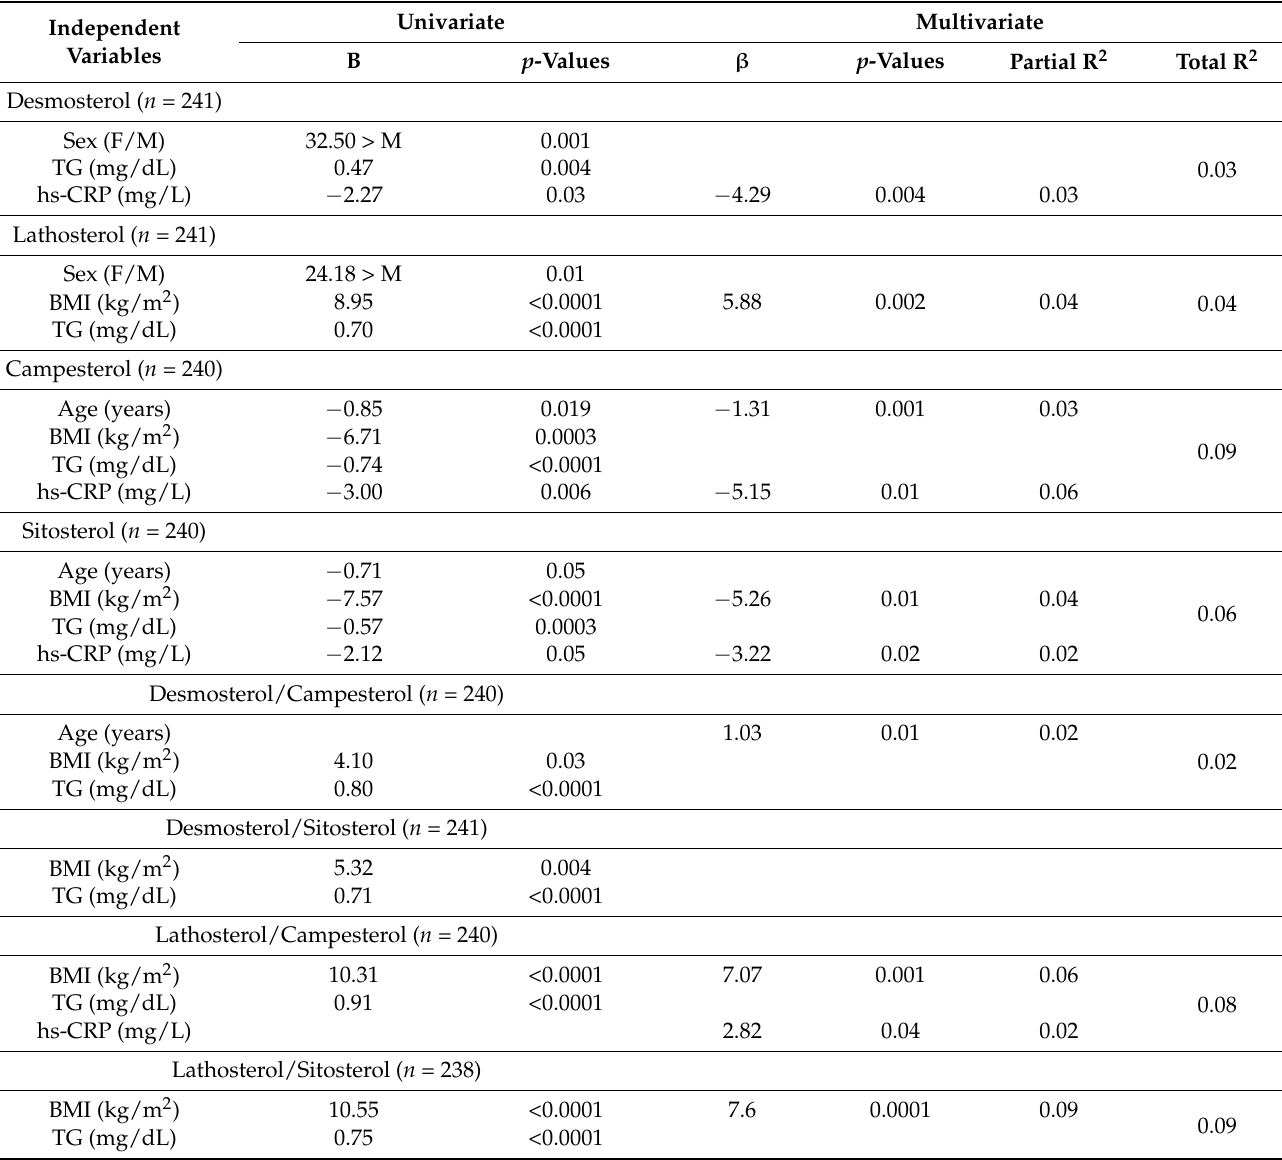
Table 3. Relationships of markers of cholesterol synthesis and absorption with classical CVD risk